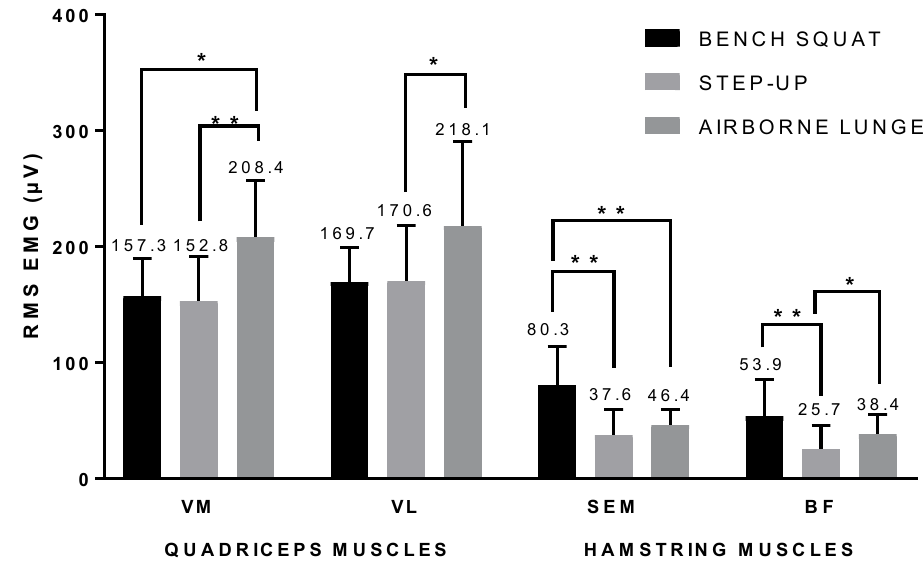
Figure 2. Multiple comparison of the RMS values in ascending phase (*:p<0.05; **:p<0.01): (VM: Vastus medialis; VL: Vastus lateralis; SEM: Semitendinosus; BF: Biceps Table 2. The mean RMS (μV) values in the descending phase during exercises Muscles Exercises